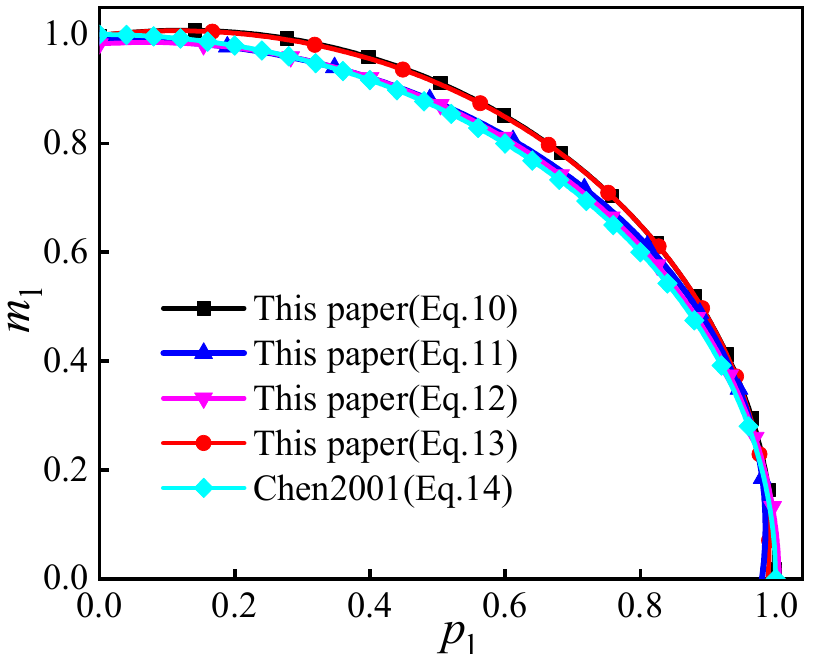
Figure 8. Comparison of the limit load equations of straight pipes with local wall-thinning defects under the combination of internal pressure and bending moment with Ref. [28].